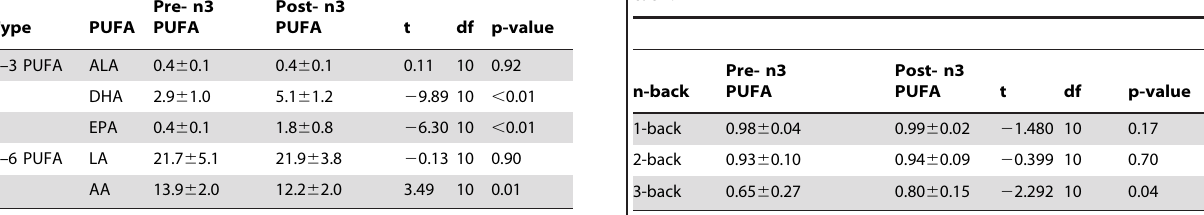
Table 2. Adjusted hit rate from the n-back working memory